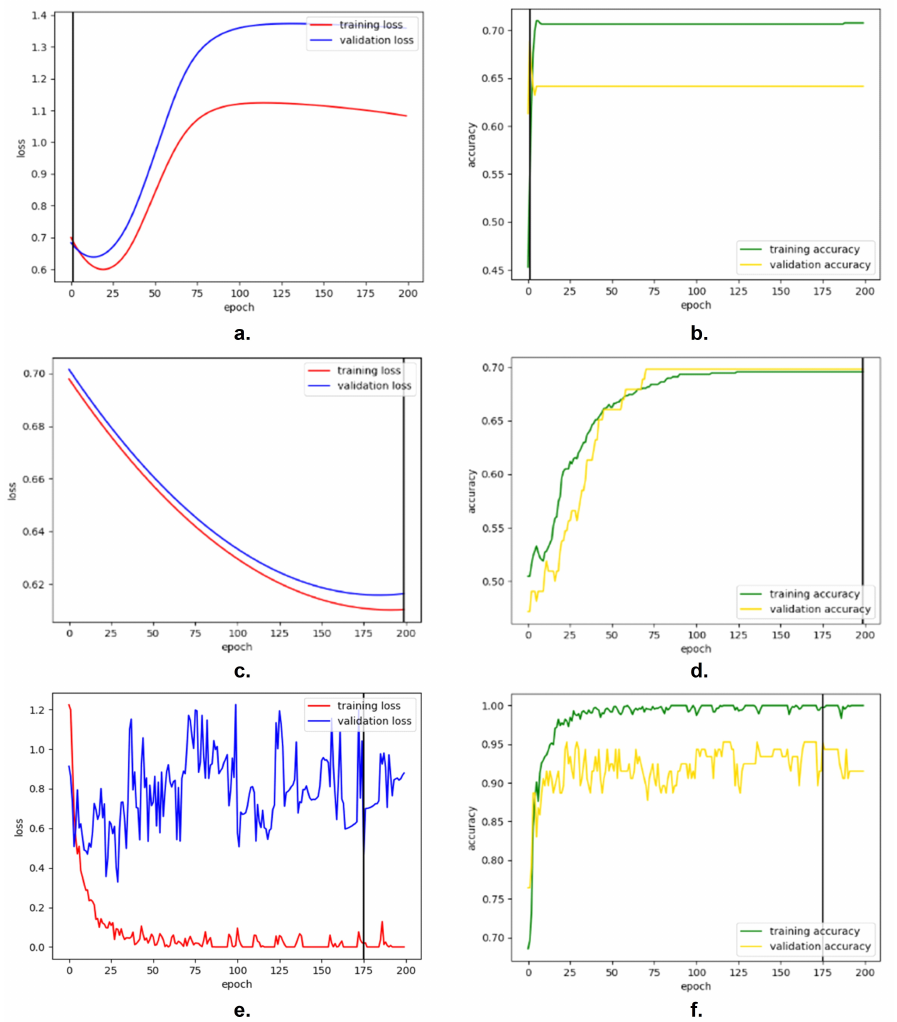
Figure 8. Loss and accuracy results for two different optimizers. ( a , b ) are results of using SGD and lr = 1 e − 3 , ( c , d ) are results of using SGD and lr = 1 e − 4 , ( e , f ) are results of using Adam and lr = 1 e − 3 , where lr is the learning rate. The black vertical line in each subfigure is the epoch having the highest validation